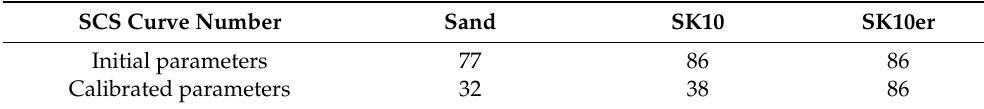
Table 10. Initial and calibrated values of parameters for different experiments using the SCS curve number method.